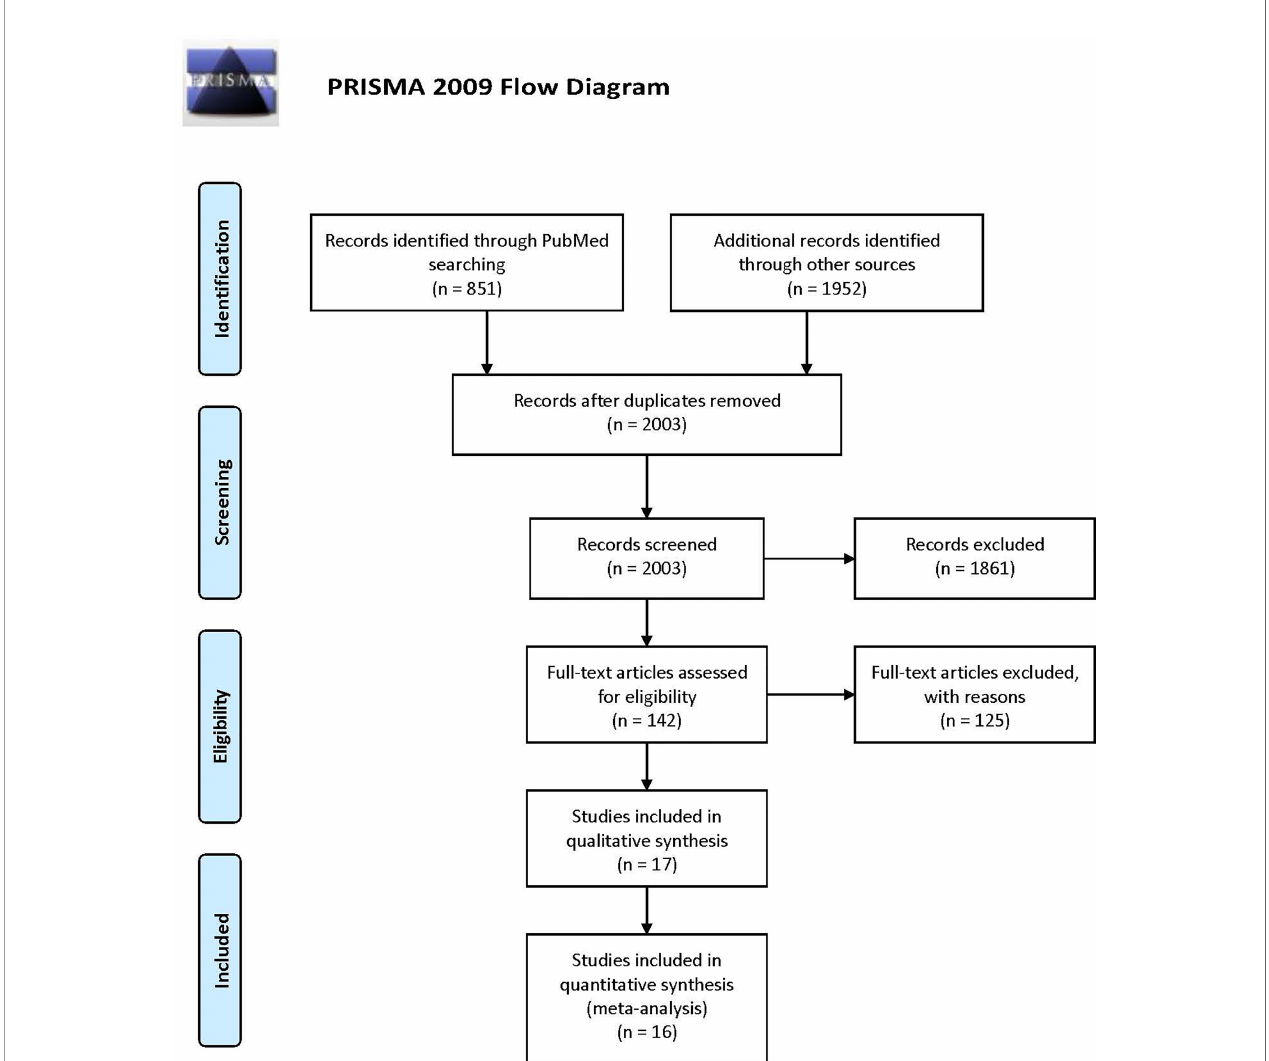
FIGURE 1 | PRISMA fl owchart describing the study identi fi cation and selection process, which was adopted to document the number of items identi fi ed from the databases, the number of duplicates removed, the number of full-text articles screened, and the number of studies included in the fi nal